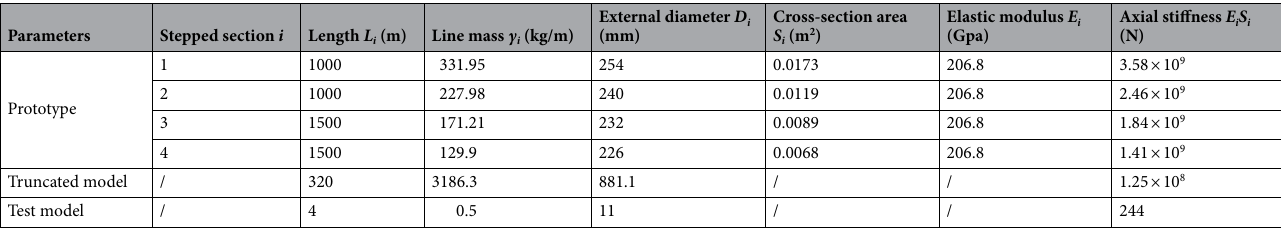
Table 3. Parameters of model and entity of lifting pipe.